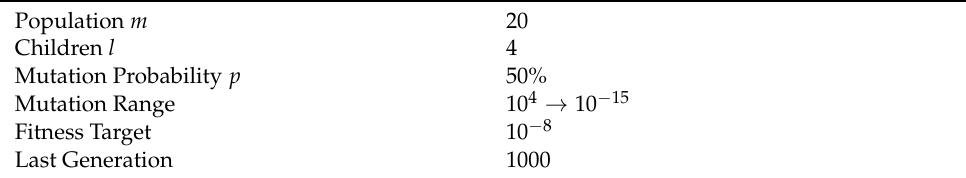
Table 4. Parameters for setting the genetic